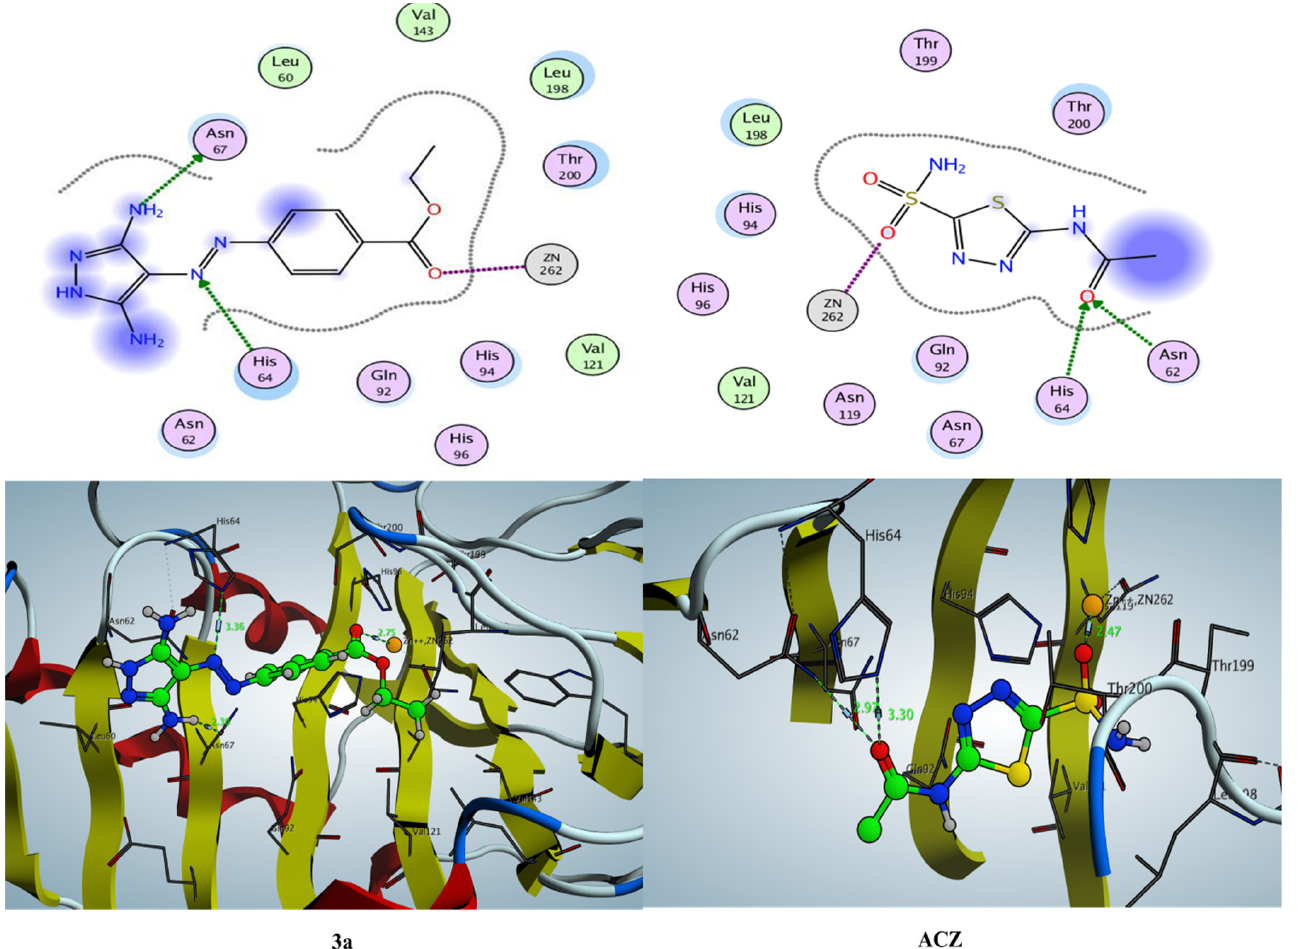
Figure 10. 2D and 3D enzyme–ligand interaction of compounds 3a and ACZ inside the active site of h CA-II. h